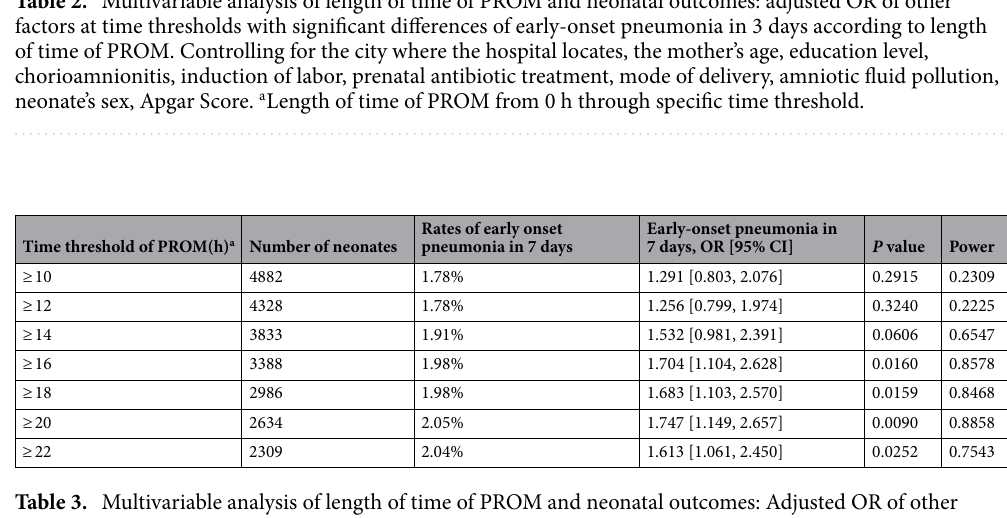
Table 3. Multivariable analysis of length of time of PROM and neonatal outcomes: Adjusted OR of other factors at time thresholds with significant differences of early-onset pneumonia in 7 days according to length of time of PROM. Controlling for the city where the hospital locates, the mother’s age, education level, chorioamnionitis, induction of labor, prenatal antibiotic treatment, mode of delivery, amniotic fluid pollution, neonate’s sex, Apgar Score. a Length of time of PROM from 0 h through specific time threshold.